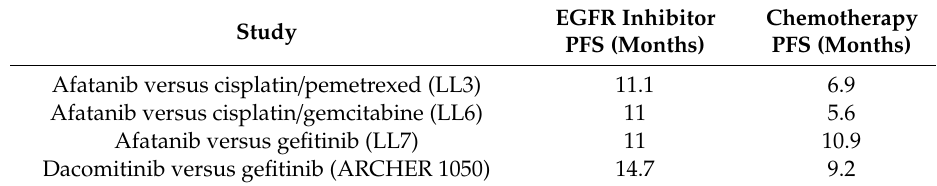
Table 2. Outcomes of second-generation EGFR tyrosine kinase inhibitors in the first-line setting. LL, Lux-Lung. EGFR Inhibitor Chemotherapy Study PFS (Months) PFS (Months) Afatanib versus cisplatin / pemetrexed (LL3) 11.1 6.9 Afatanib versus cisplatin / gemcitabine (LL6) 11 5.6 Afatanib versus gefitinib (LL7) 11 10.9 Dacomitinib versus gefitinib (ARCHER 1050) 14.7